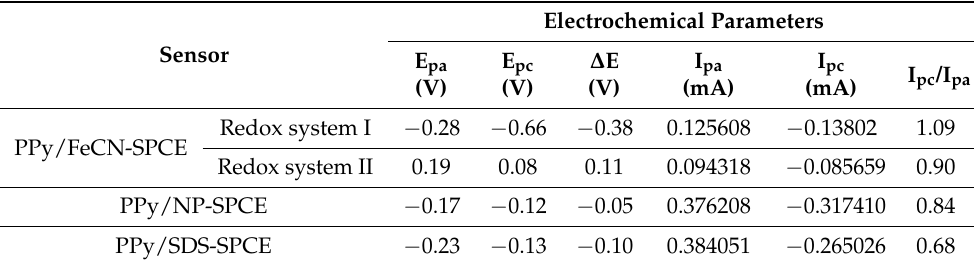
Table 3. The potential and intensity of peaks of PPy modified sensors immersed in a 0.1 M KCl